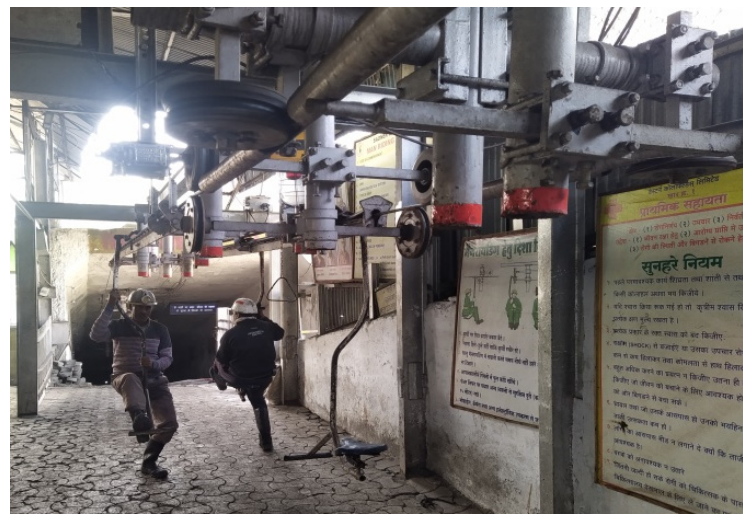
Figure 3. Embarking and Disembarking Station.